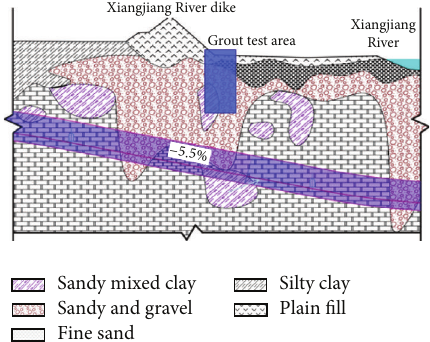
Figure 2: West part longitudinal geological profile of north line (vertical scale 1: 500 and horizontal scale 1:1000) [26].